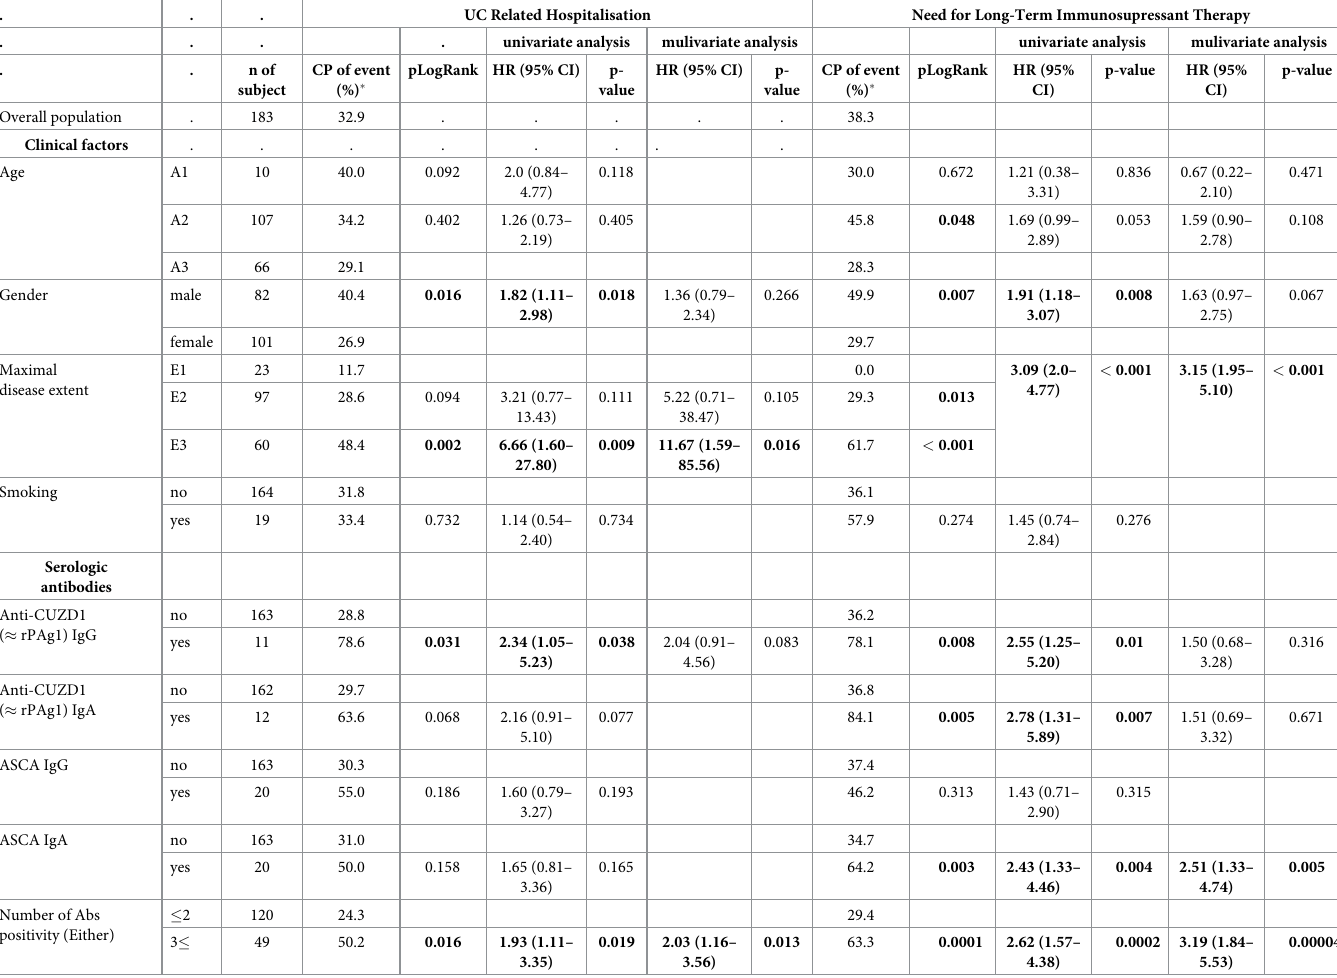
Table 5. Univariate and multivariate Cox-regression analysis evaluating association between clinical and serologic variables and the study end-point events (ulcera- tive colitis-related hospitalization and need for immunosuppressant therapy).